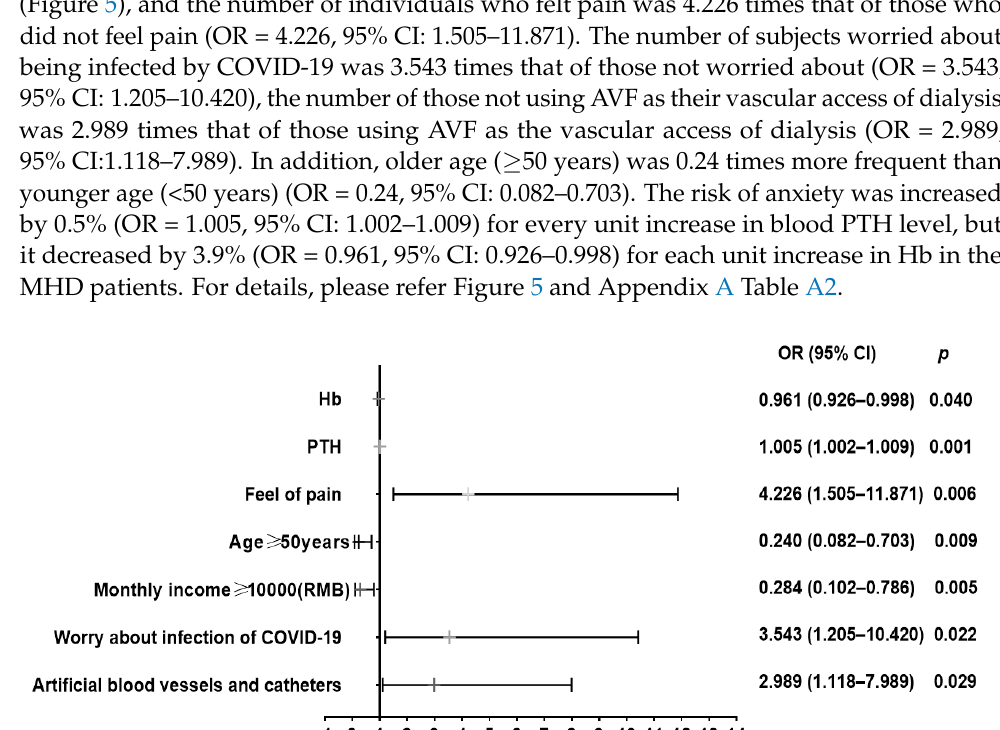
Figure 6. Logistic analysis of risk factors of depression in the MHD patients. 4. Discussion 4.1. Anxiety and Depression of the MHD Patients during the COVID-19 Chronic kidney disease (CKD) is a global health problem characterized by high mor- bidity, complications, disability and mortality. The rapid increase in the number of pa- tients with CKD and end-stage renal disease has caused a heavy social and economic bur- den. The prevalence of CKD in China has exceeded 10%, meaning that at least 1 in 10 people has CKD, and CKD is predicted to become the fi fth leading cause of death world- wide by 2040. The MHD patients have many psychological problems even under general circum- stances. Before the COVID-19, 20% of the MHD patients su ff ered from mental health prob- lems [9]. Meanwhile, 35.6% and 38.9% of investigated MHD patients presented as having anxiety and depression, respectively, even during the period of regular preventive and control of COVID-19 in our study, which is signi fi cantly higher than previously. Our fi nd- ings are similar with the report conducted in China regarding the MHD patients’ mental health during the COVID-19 pandemic [10,11]. The incidence of mental problems in the present study was obviously higher than that of the Polish and German young adults (18– 35 years old) (16.2% and 30% for anxiety and depression, respectively), as well as the result in India during the locked down and quarantined period of the COVID-19 pandemic (25%) [8,12,13]. Data from other countries showed that the mortality of the patients with chronic diseases was more than six times that of those without chronic diseases after being